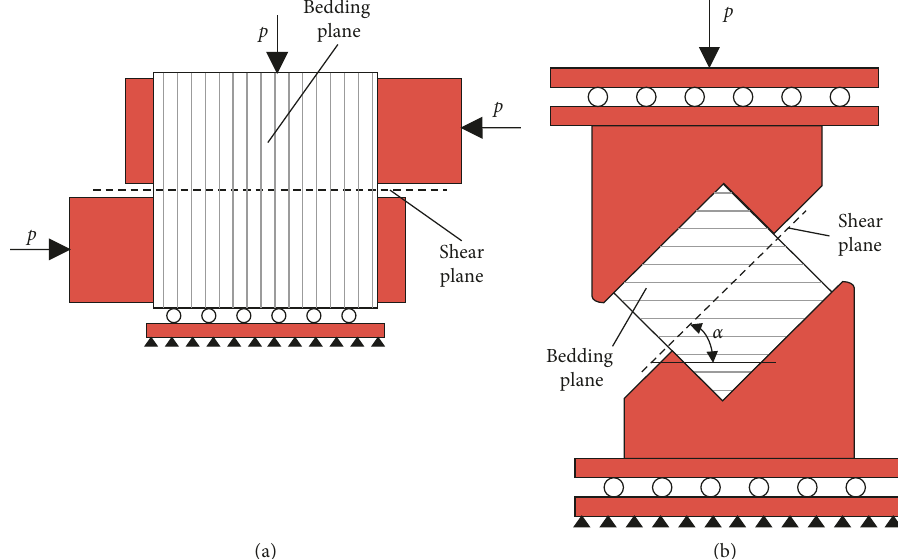
Figure 2: Shear test loading modes comparison. (a). Shear test with cylindrical specimens. (b). Shear test with cube left on the test platform, leaving the shear plane of the specimen very smooth. In condition b, failure was on the two sides of the shear plane. As shear moving occurred between the upper and lower parts of the specimen, tensile failure appeared along the bedding plane.